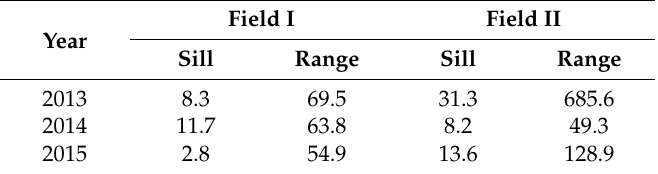
Table 9. Sill and range values for the small-scale variogram for the agricultural field I and II (Figure 9). Year Field I Field II Sill Range Sill Range 2013 8.3 69.5 31.3 685.6 2014 11.7 63.8 8.2 49.3 2015 2.8 54.9 13.6 128.9